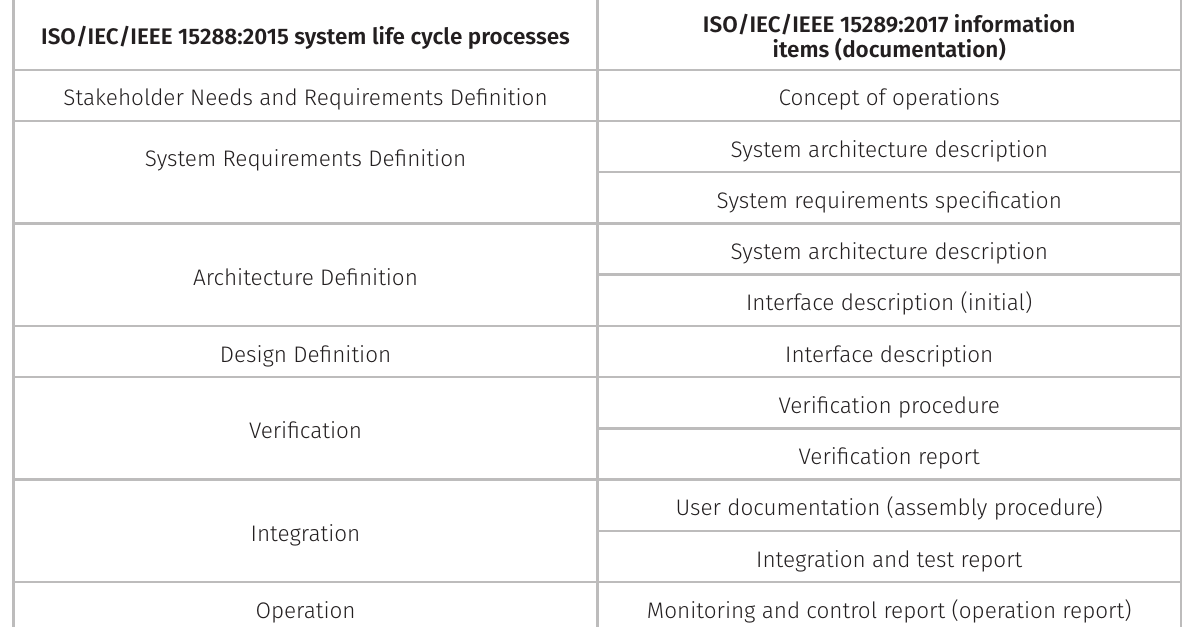
ISO/IEC/IEEE 15289:2017 information items (documentation)